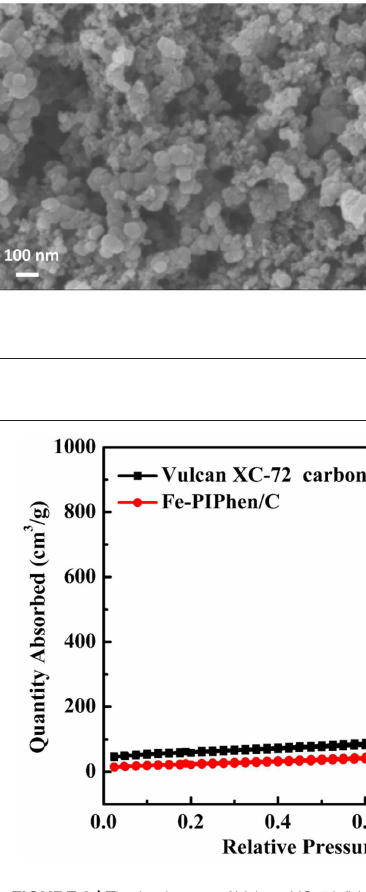
of spherical particles with an average particle size of 35–60 nm ( Figure 2A ), and the irregular aggregation of the particles forms a porous structure on the surface of the electrode. For Fe- PIPhen/C ( Figure 2B ) composite, the average radius (40–60 nm) is higher than that of the average radius of Vulcan XC-72 carbon particles, which was the result from the coating of